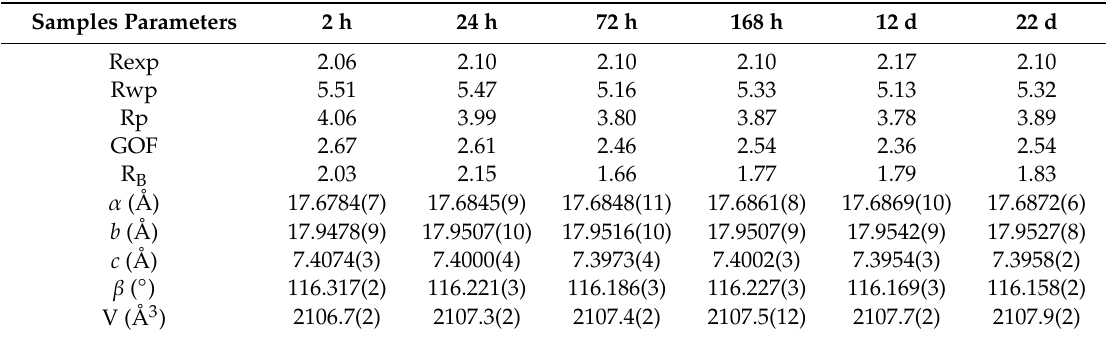
Table 4. Reliability factors (Rexp, Rwp, Rp, GOF, R B ) and refined unit cell parameters of Ba-clinoptilolite from the ion exchange sequence at 90 ◦